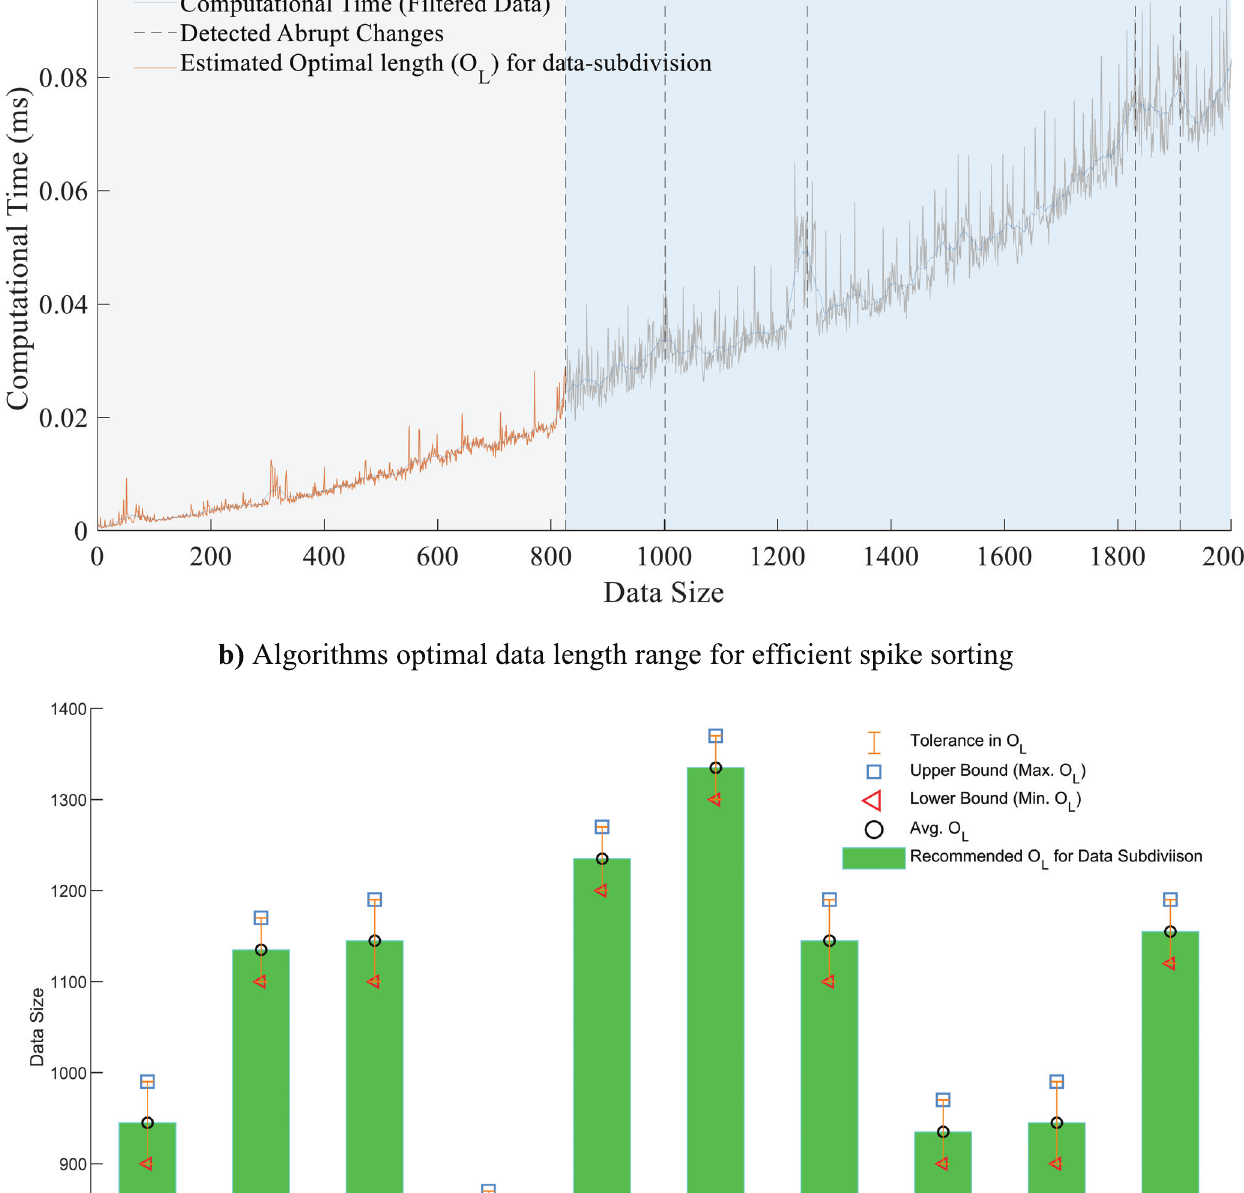
PLOS ONE | https://doi.org/10.1371/journal.pone.0245589 February 10, 2021 9 /